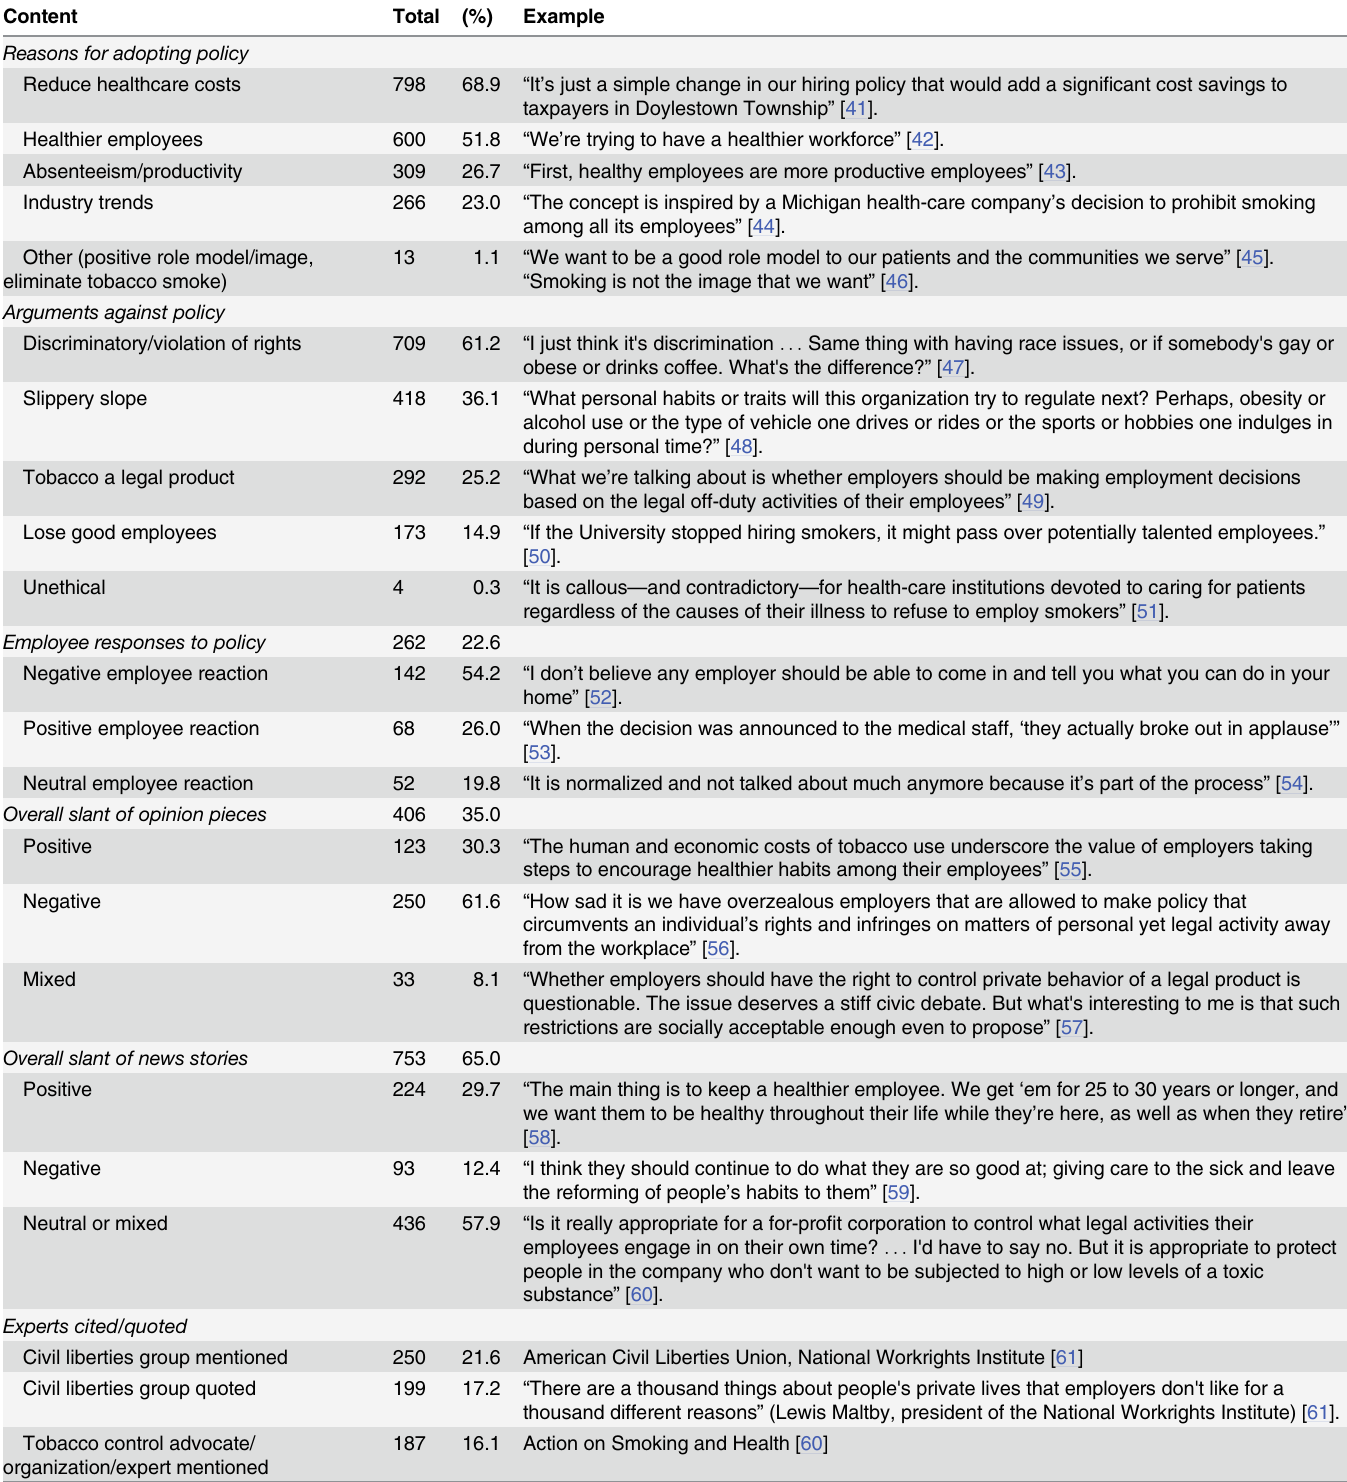
Table 2. Content of news items (n = 1,159) concerning employers with policies to hire only nonsmokers: United States, 1995 –